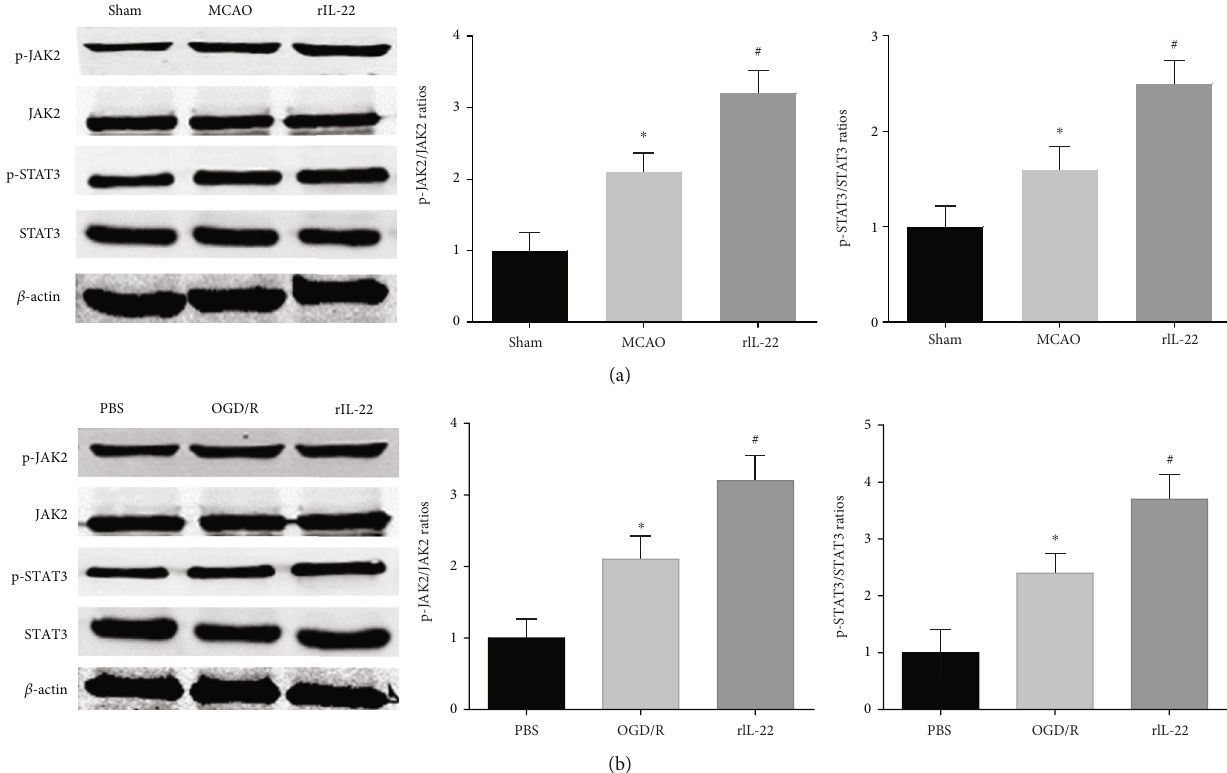
Figure 6: IL-22 treatment activated the JAK2/STAT3 signaling pathway. (a) The expression of p-JAK2, JAK2, p-STAT3, STAT3, and β -actin in the brain was detected by western blotting ( n = 4 ). (b) The expression of p-JAK2, JAK2, p-STAT3, STAT3, and β -actin in PC12 cells was detected by western blotting ( n = 4 ). ∗ P < 0 : 05 vs. the sham or PBS group; # P < 0 : 05 vs. the MCAO or OGD/R